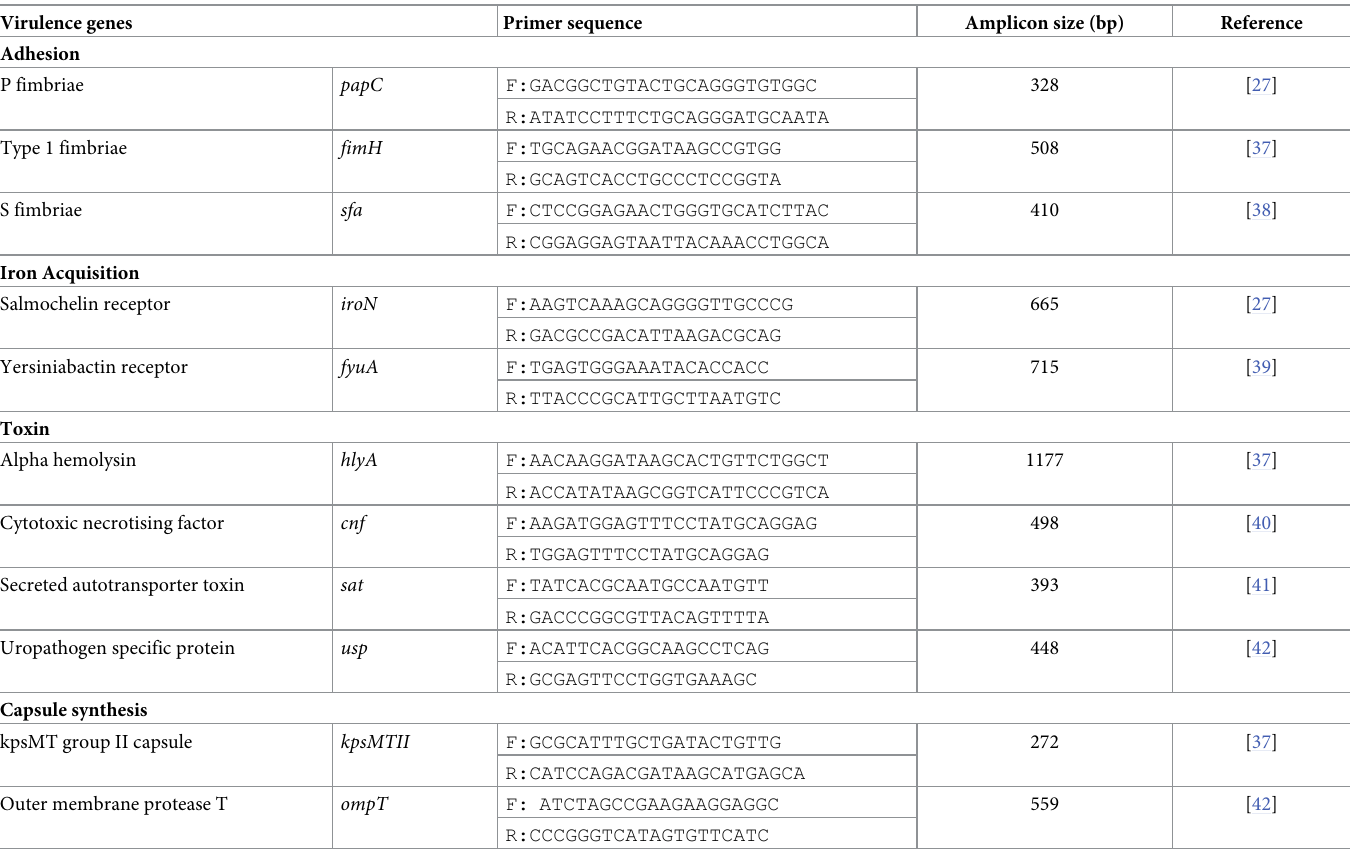
Table 2. List of Primers used in virulence